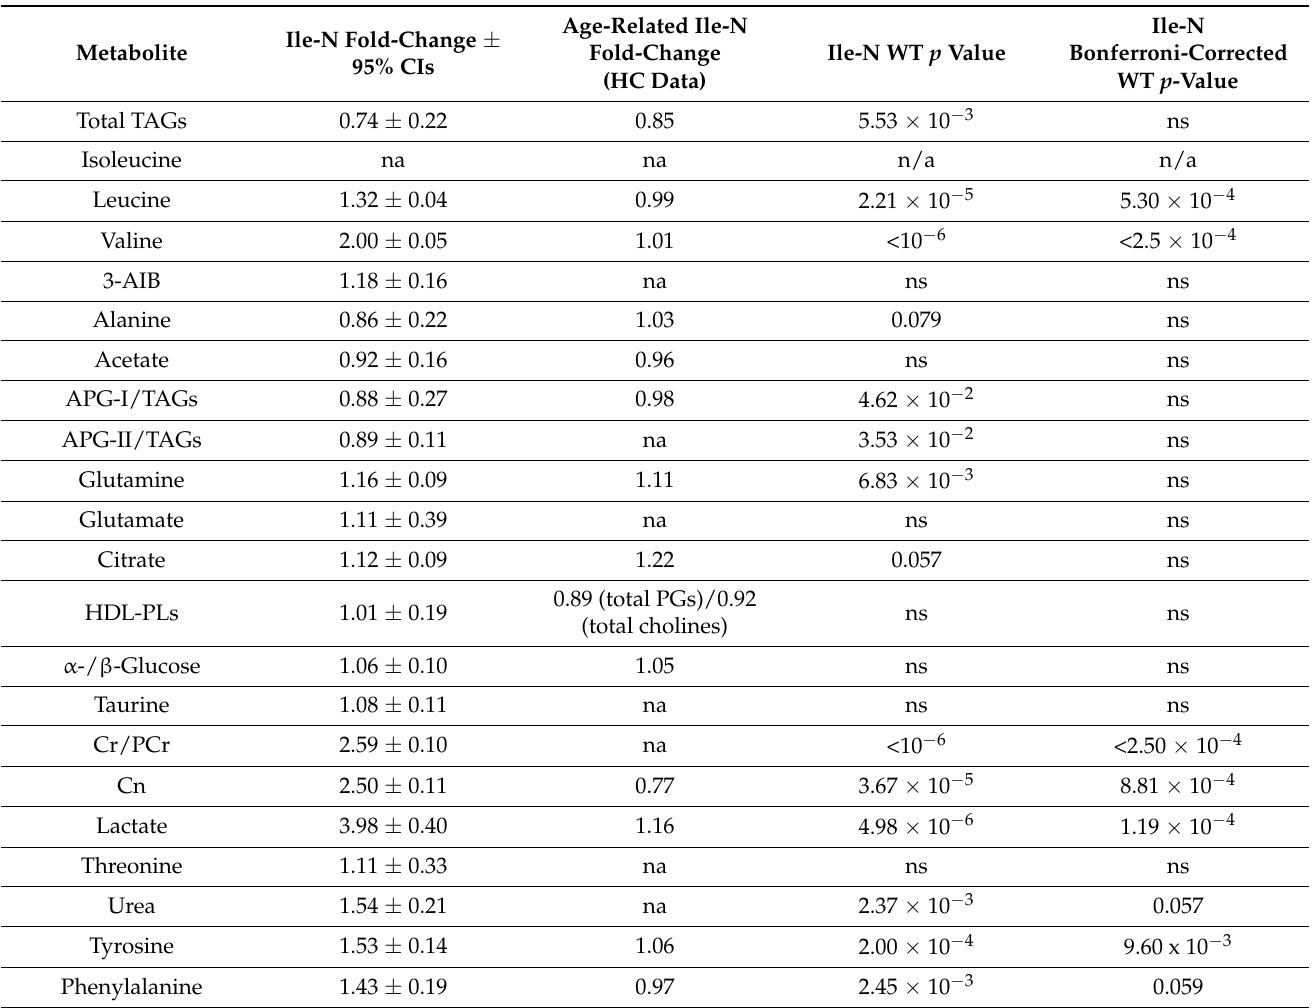
Table 3. Statistical significance and nature of differences between the 1 H NMR-detectable, Ile-normalized (Ile-N) plasma metabolite levels of GM1T2 and HC